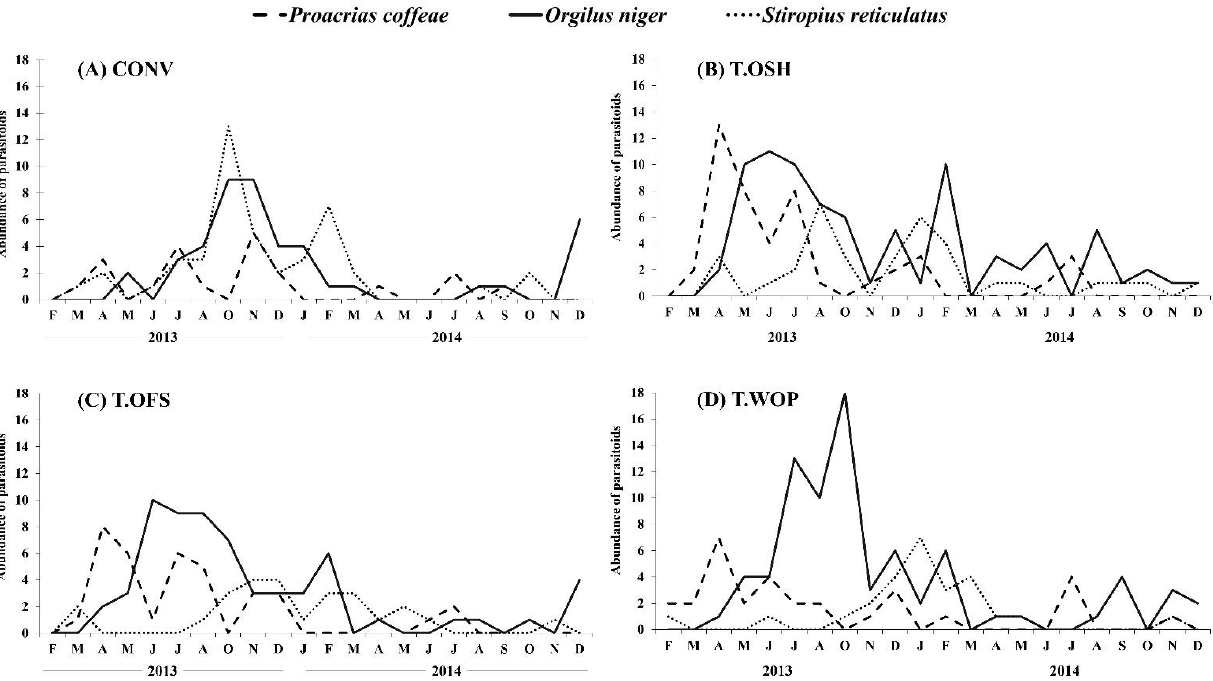
Figure 2. Population fluctuations of Braconidae and Eulophidae in the conventional system (CONV) and systems in transition to organic shaded (T.OSH), organic full-sun (T.OFS), and without pesticides (T.WOP). Campo do Meio and Guapé, MG, Brazil, February 2013 to December 2014.